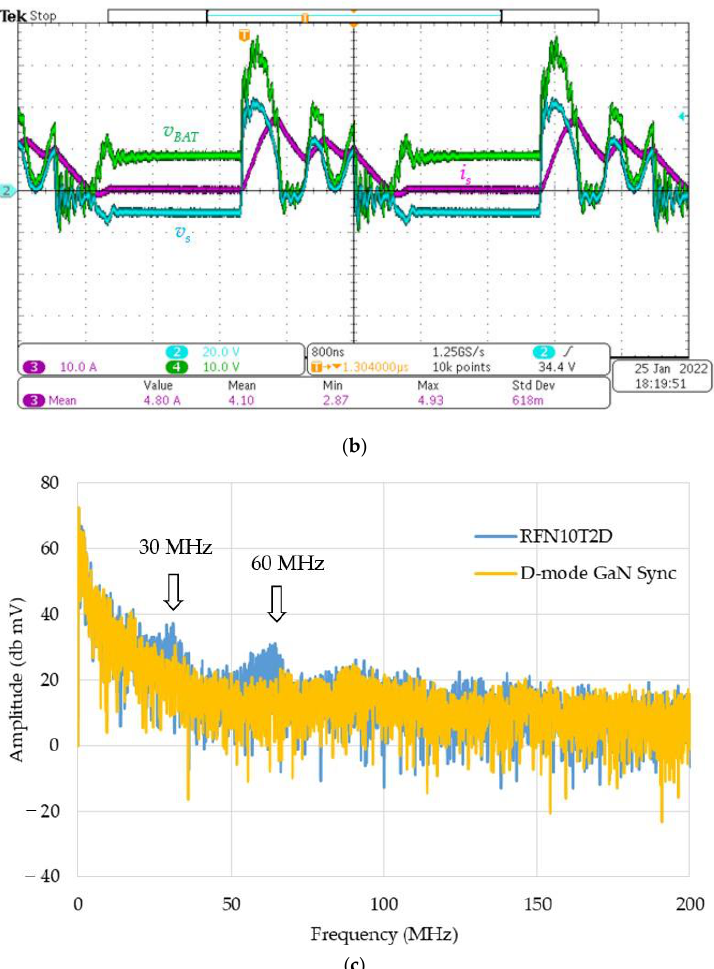
Figure 14. Waveform of 72 V input, 12 V/5.05 A flyback converter with ( a ) diode (RFN10T2D) and ( b ) D-mode GaN HEMT SR. ( c ) Comparison of the transformer secondary voltage ( v s ) frequency spectrums.